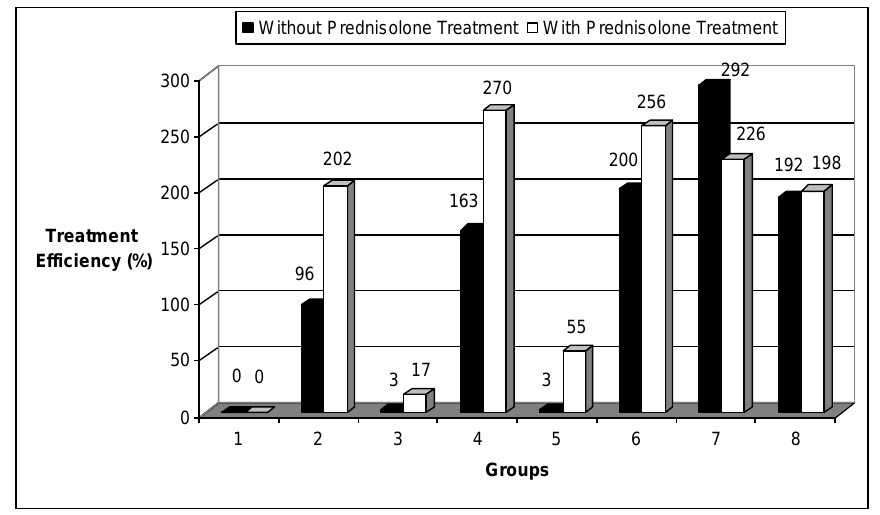
Figure 1: Treatment efficiency of IFN-γ serum level in treated mice One of the cytokines is IFN-γ, which was evaluated in the present study through different experiments in regard to Brucella vaccination and immunomodulators (mannoproteins and neem extracts). The results demonstrated a significant increased serum level of IFN-γ in mice treated with the tested immunomodulators especially groups without prednisolone treatment because of the immunosuppressed effect of prednisolone. Such findings highlight the importance of ethanolic and aqueous neem seed extracts, as well as, mannoproteins of C . albicans cell wall as immunomodulators, especially when we consider the immunological importance of IFN-γ in enhancing the cellular immune response, which is important in controlling Brucella